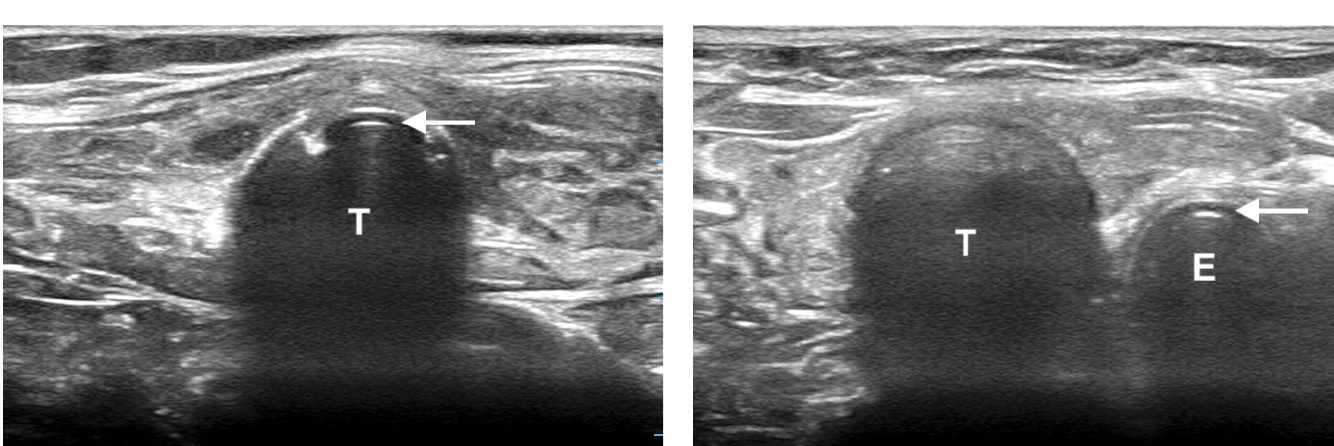
Figure 2. Esophageal intubation imaged with the static technique. T , trachea; E , esophagus; white arrow, endotracheal